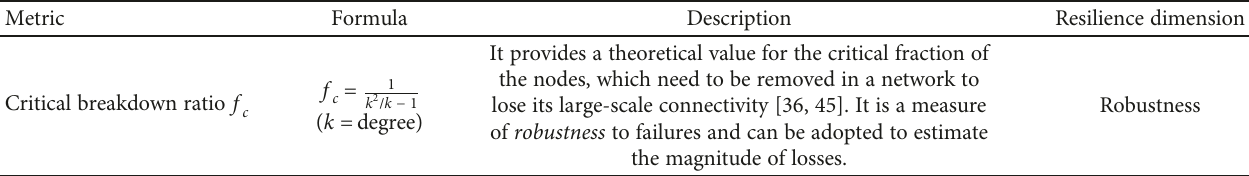
Table 6: Economic dimension of resilience: GT measures related to the hard infrastructural